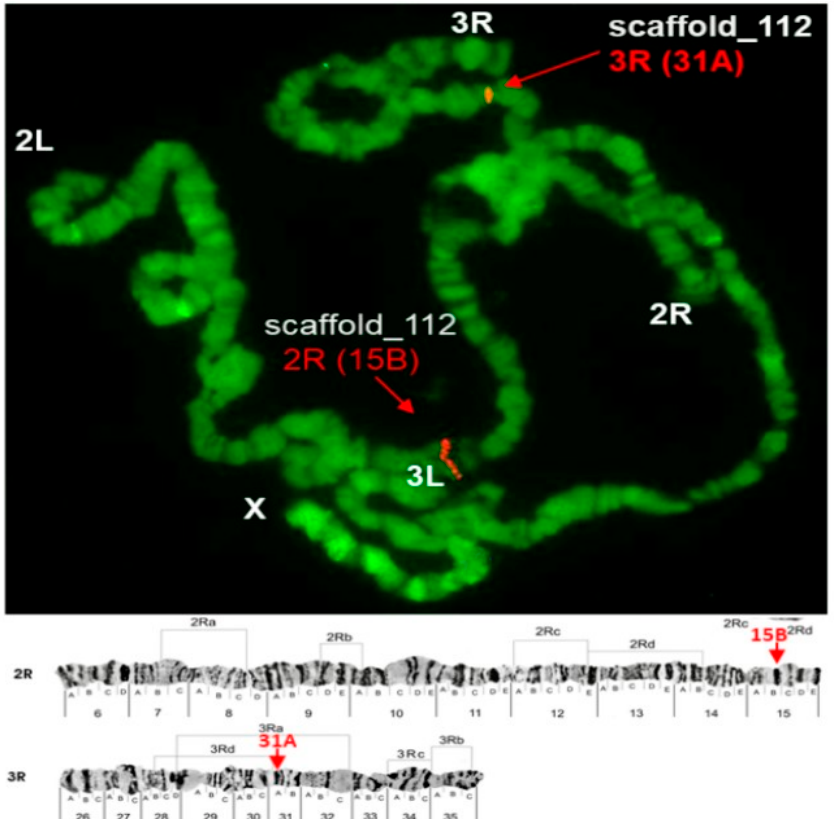
Figure 2. Pb5r-Cy3 mapped in 2R (15B) and 3R (31A), as shown by arrows. Chromosomal bands with positive hybridization are identified with text in red, and the corresponding scaffolds in An. darlingi genome assembly AdarC3 are indicated in white text.